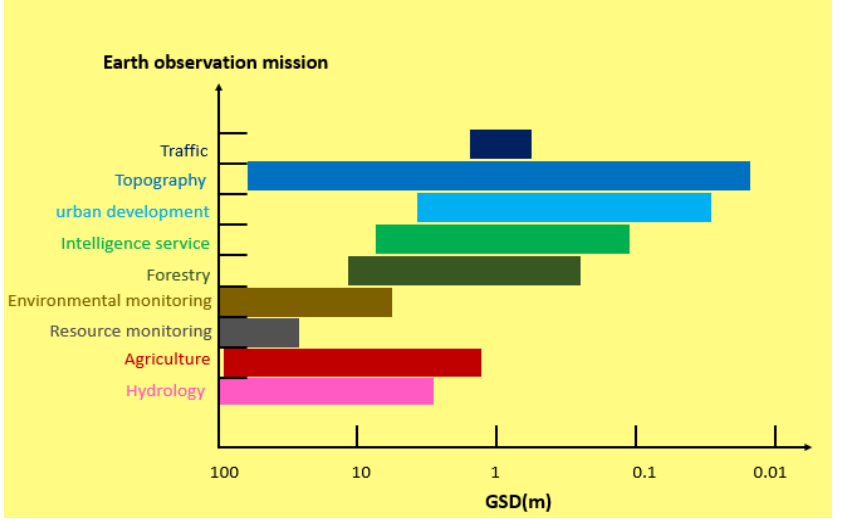
Figure 2. Common Earth observation missions and their resolution in practical